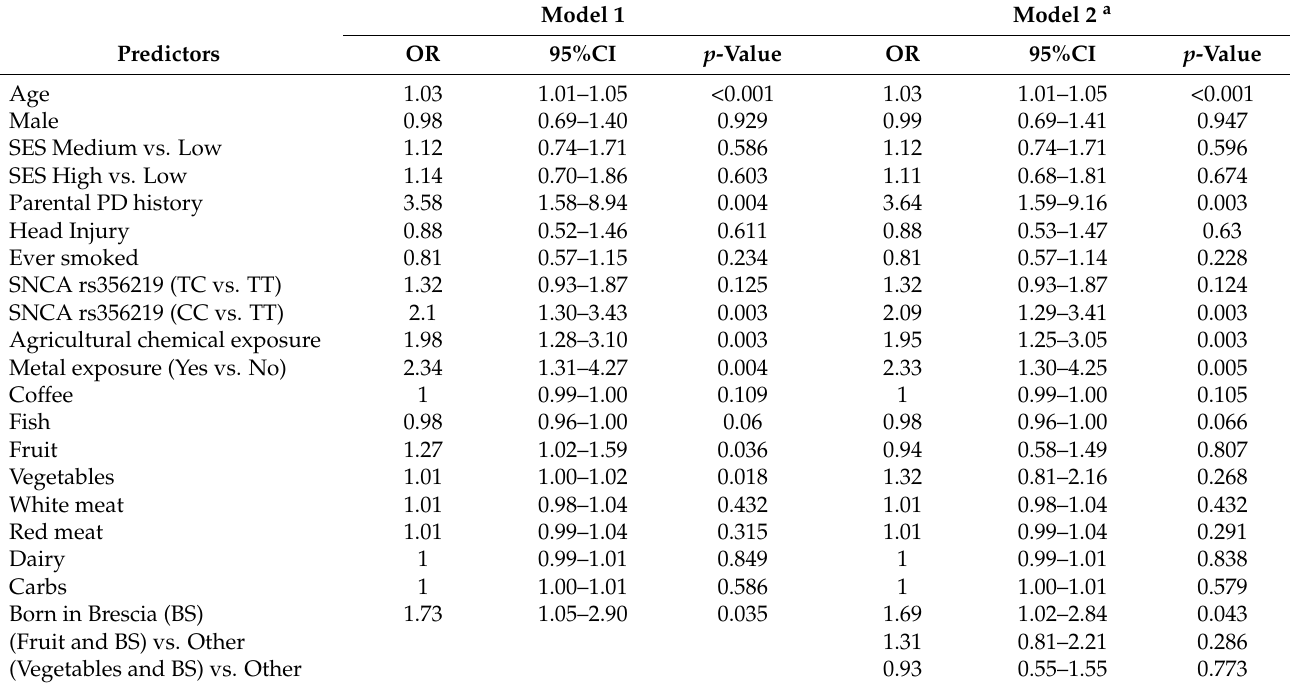
Table 2. Logistic regression results demonstrating the odds ratios (OR), 95% Confidence Intervals (CI), and p -values for the association between environmental, genetic, and dietary predictors and PD. Model 1 Model 2